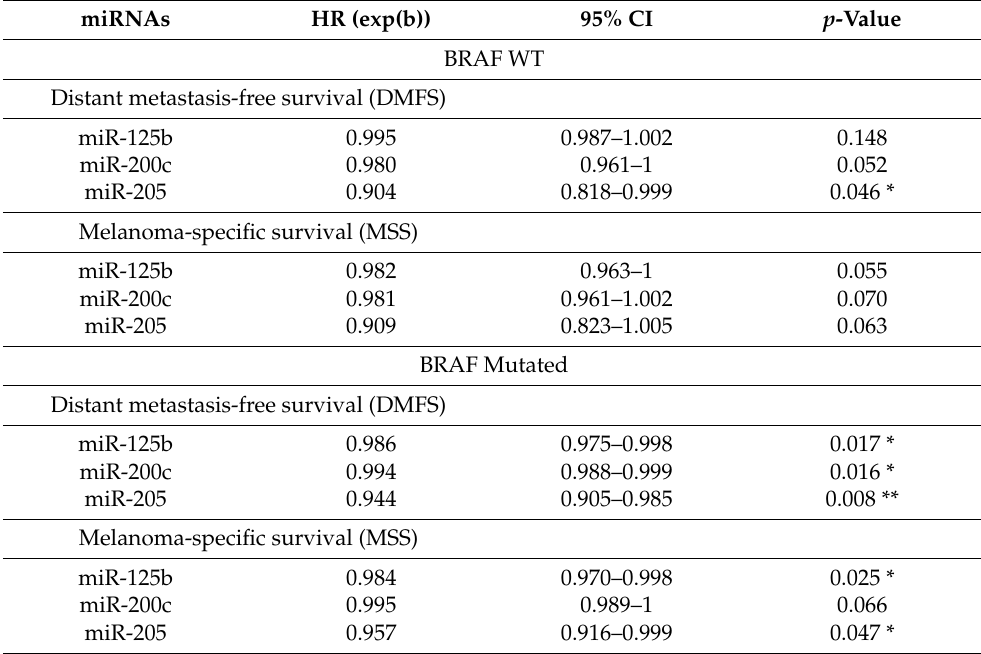
Table 3. Univariate Cox regression analysis of miRNAs for DMFS and MSS. miRNAs HR (exp(b)) Distant metastasis-free survival